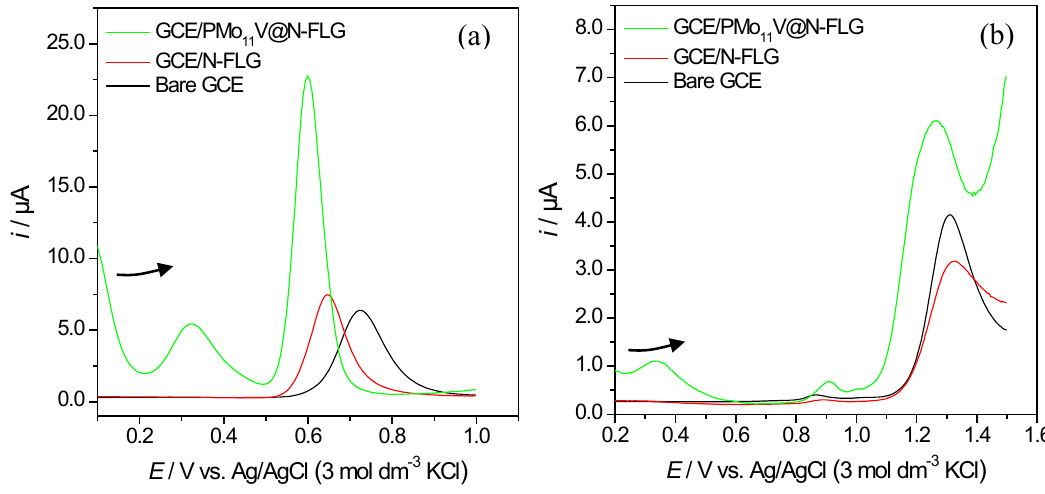
Figure 5. Square wave voltammograms of 5.0 × 10 − 4 mol dm − 3 AC ( a ) and TP ( b ) at a bare GCE, N-FLG/GCE and PMo 11 V@N-FLG/GCE in pH 2.5 H 2 SO 4 /Na 2 SO 4 buffer solution, scan rate 0.050 V s − 1